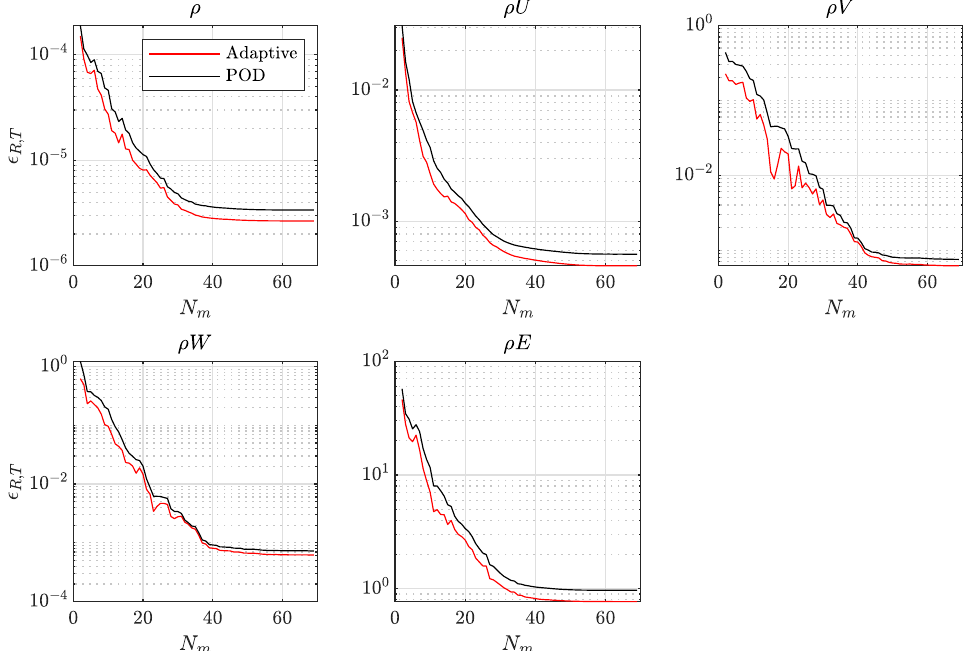
Figure 12. The log 10 ( (cid:101) R,T ) varying the number of modes, for adaptive ROM and POD, delta wing test case.